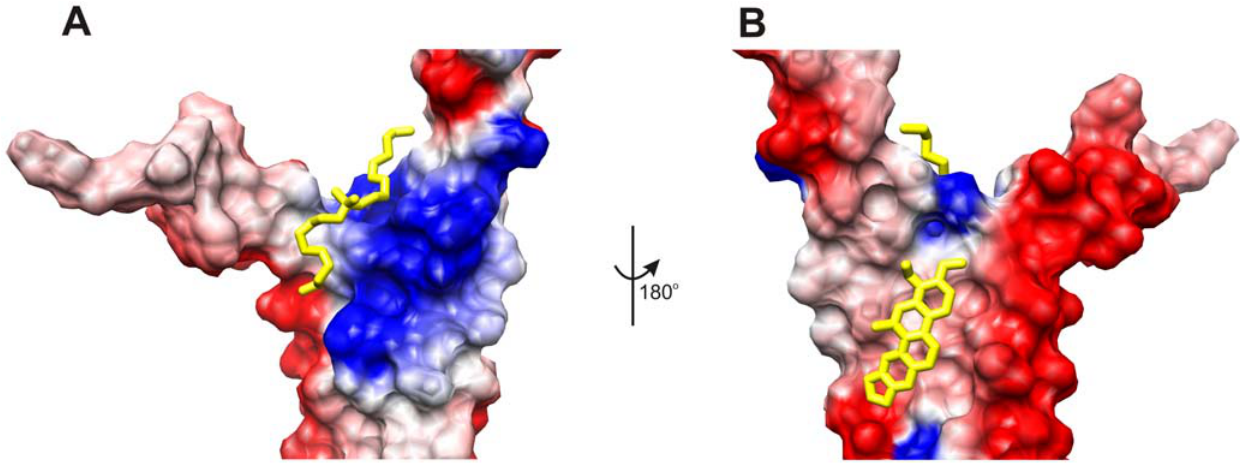
Figure 4. The two PrgI ligand binding sites identified using FAST-NMR. The two PrgI ligand binding sites are highlighted on an electrostatic potential surface (blue positive charge, red negative charge) calculated with DelPhi [79] implemented in Chimera [80]. The didecyldimethylammonium bromide binding site (A) is found in a region responsible for needle formation while the chelerythrine binding site (B) is found on the opposite face.